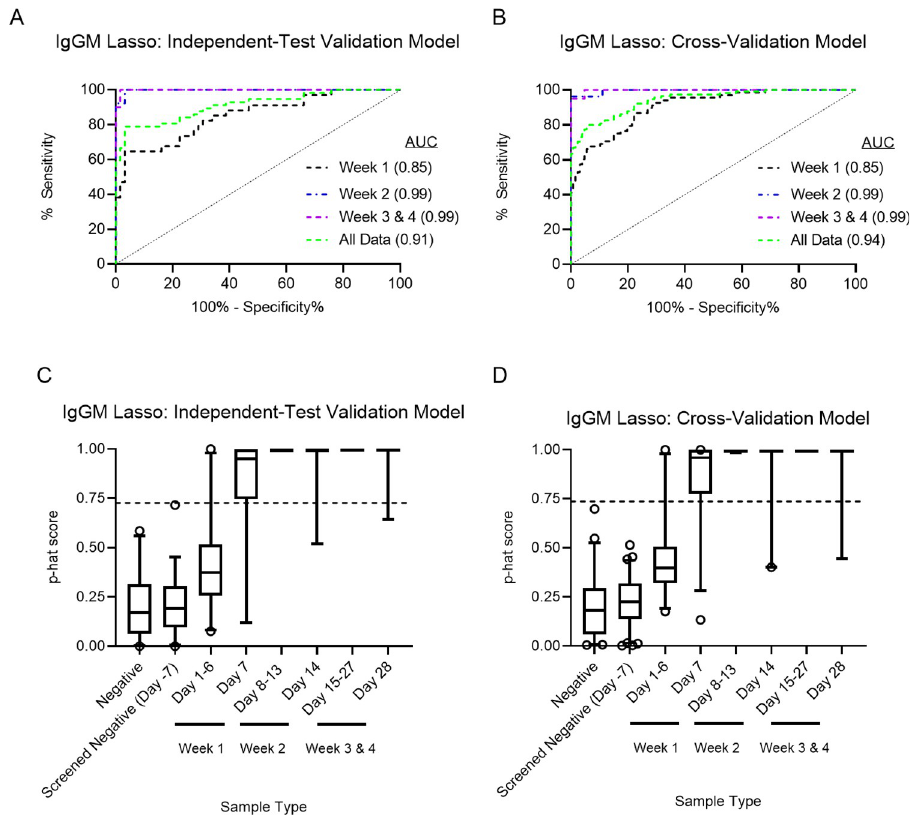
Fig 4. Receiver Operator Characteristic (ROC) plots and box and whisker plots of the IgGM Lasso multiple antigen models. ^ p ^ -scores (p-hat) were generated from median fluorescent intensity values of all antigens for IgM and IgG. (A and C) Independent test validation and (B and D) cross-validation performance LASSO models are